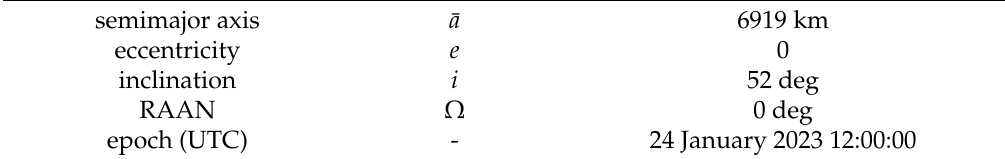
Table 4. Mid-inclination LEO formation: orbit parameters of chief